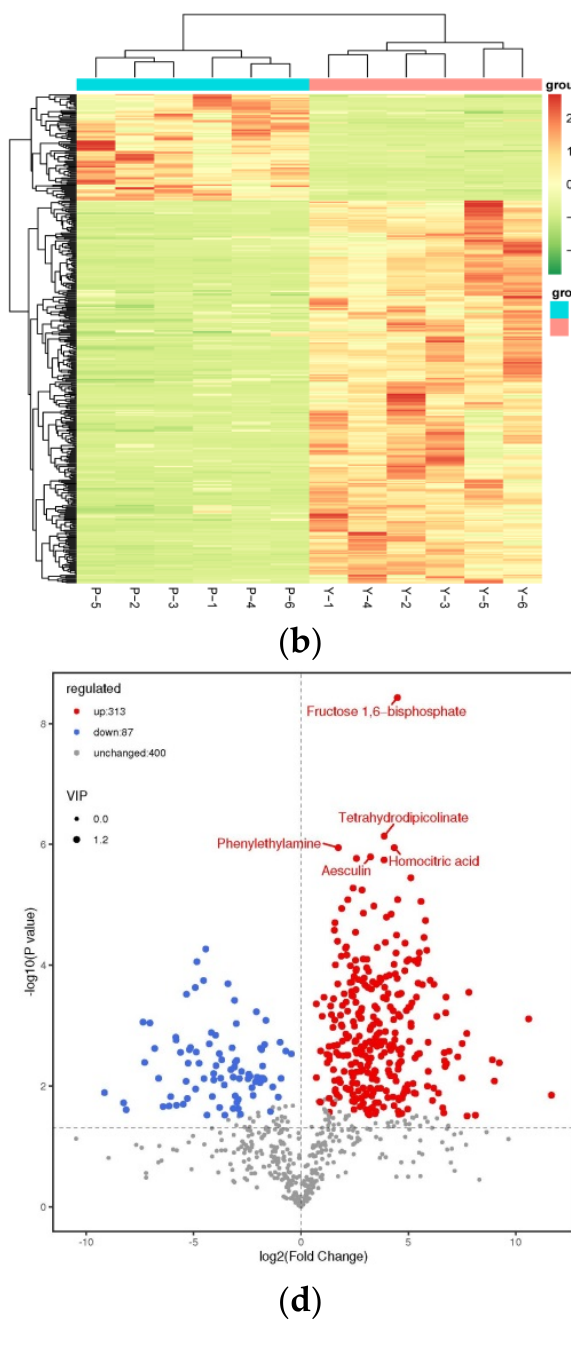
Figure 1. Multivariate statistical analysis of metabolites in the P (bark) and Y (leaves) of H. chrysantha . ( a ) PCA score map of metabolites in the P and Y samples. ( b ) Heatmap of metabolites in the P and Y samples. ( c ) OPLS-DA model diagram of differential metabolites in the P and Y samples. ( d ) Volcanic map of differential metabolites in the P and Y samples. Red dots represent upregulated metabolites, blue dots represent down-regulated metabolites, and gray dots represent unchanged metabolites.